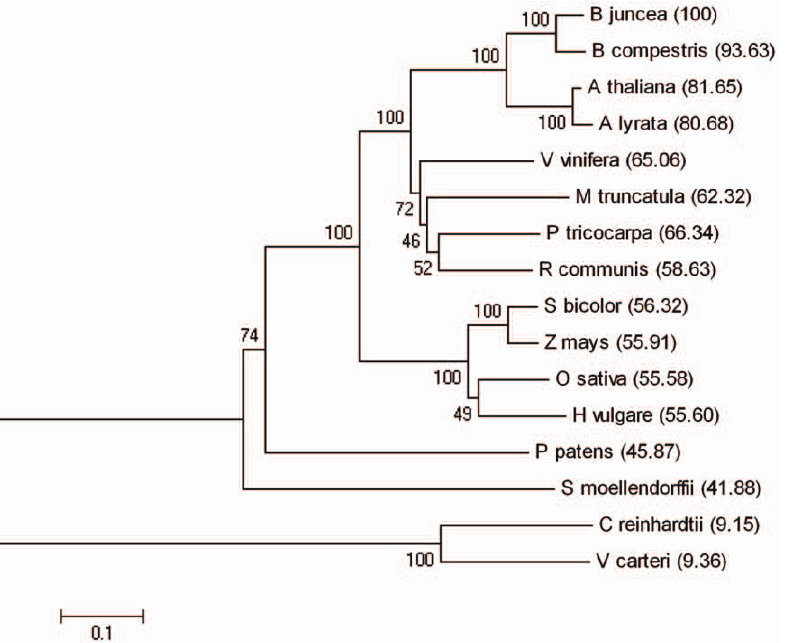
Figure 1. Evolutionary relationship among ERD4 homologs. Evolutionary relationship was inferred using the Neighbor-Joining method in MEGA4 software. The percentage of replicate trees in which the associated taxa clustered together in the bootstrap test (100 replicates) is shown next to the branches. The tree is drawn to scale with branch lengths in the same units as those of the evolutionary distances used to infer the phylogenetic tree. The evolutionary distances are in the units of the number of amino acid substitutions per site. Also shown in brackets are the pair-wise percentage identity between B. juncea ERD4 and other plant proteins, including green algae.